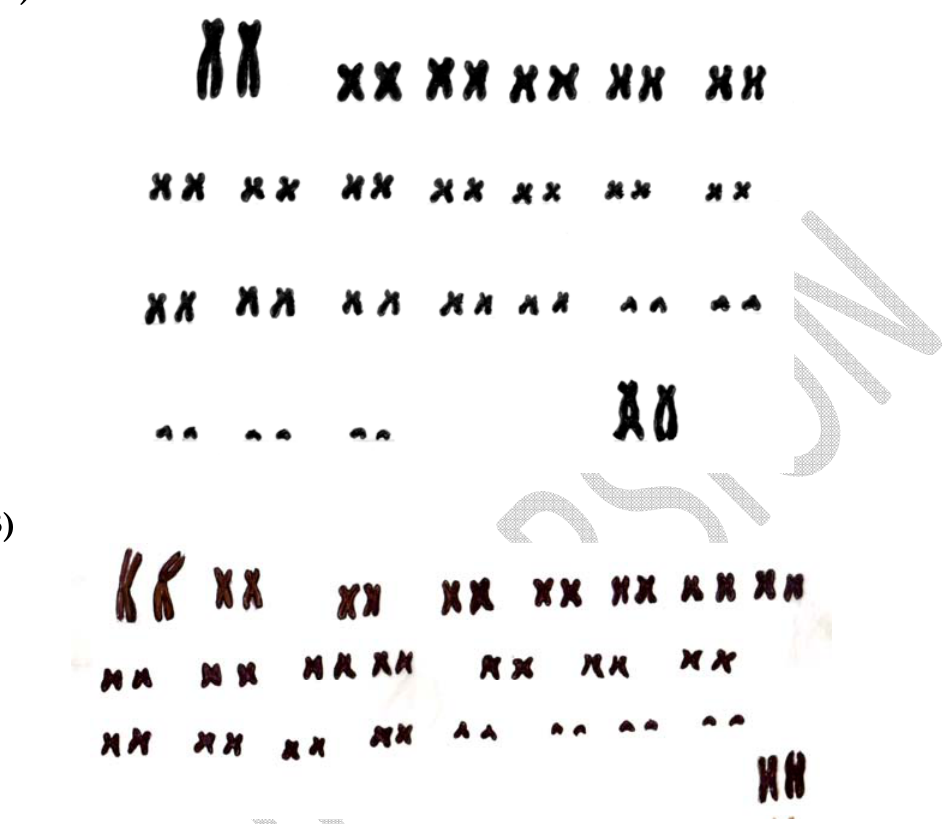
5._ F IG . Comparison of Karyotype of Jaculus thaleri (A) and J. blanfordi